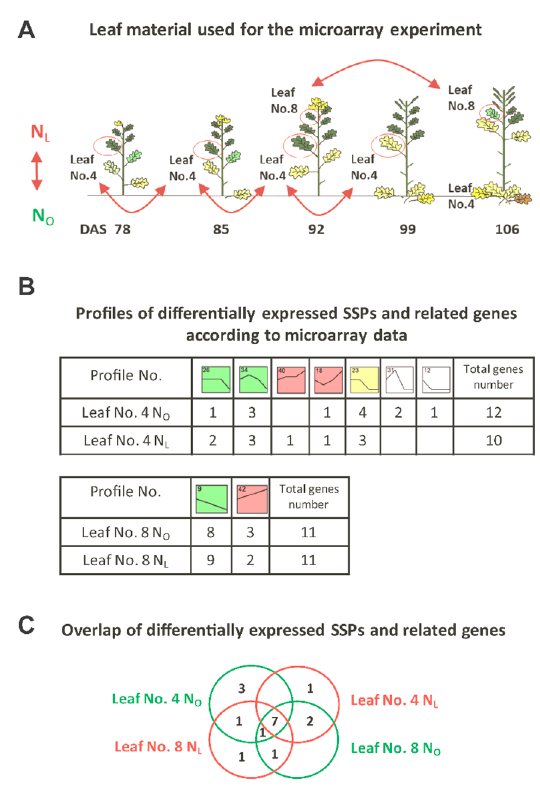
Figure 1. SSPs and related genes differentially expressed during development and/or N-supply assigned to 9 different expression profiles. ( A ) Illustration of the leaf material used in the microarray experiment (modified after Safavi-Rizi et al. [19]). Leaf No. 4 was analyzed at 4 different time points, leaf No.8 was analyzed at 2 different time points under N L or N O supply, respectively. ( B ) Number of SSPs and related genes, which were differentially expressed in leaf No. 4 and leaf No. 8 under N L and under N O conditions. Each box represents one of 50 pre-defined expression profiles [19]. The number of each model expression profile is shown in the top left corner of each box, all colored profiles contain a significant number of temporally and N-dependently regulated genes. Profiles with the same color are very similar and defined as one cluster in Safavi-Rizi et al. [19]. ( C ) Overlap of differentially expressed SSPs and related genes between leaf No. 4 and No. 8 and the growth conditions N L and N O